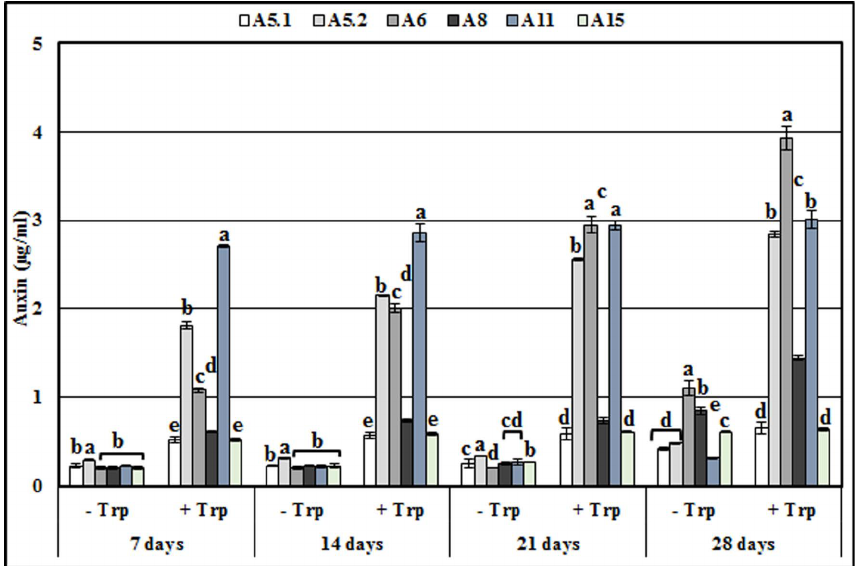
Figure 7. Production of IAA by the six isolated fungi in the presence or absence of L-Tryptophan during 7, 14, 21 and 28 days of incubation. Values represent means and standard deviations (n = 5), where samples labelled with different letters are significant at p <